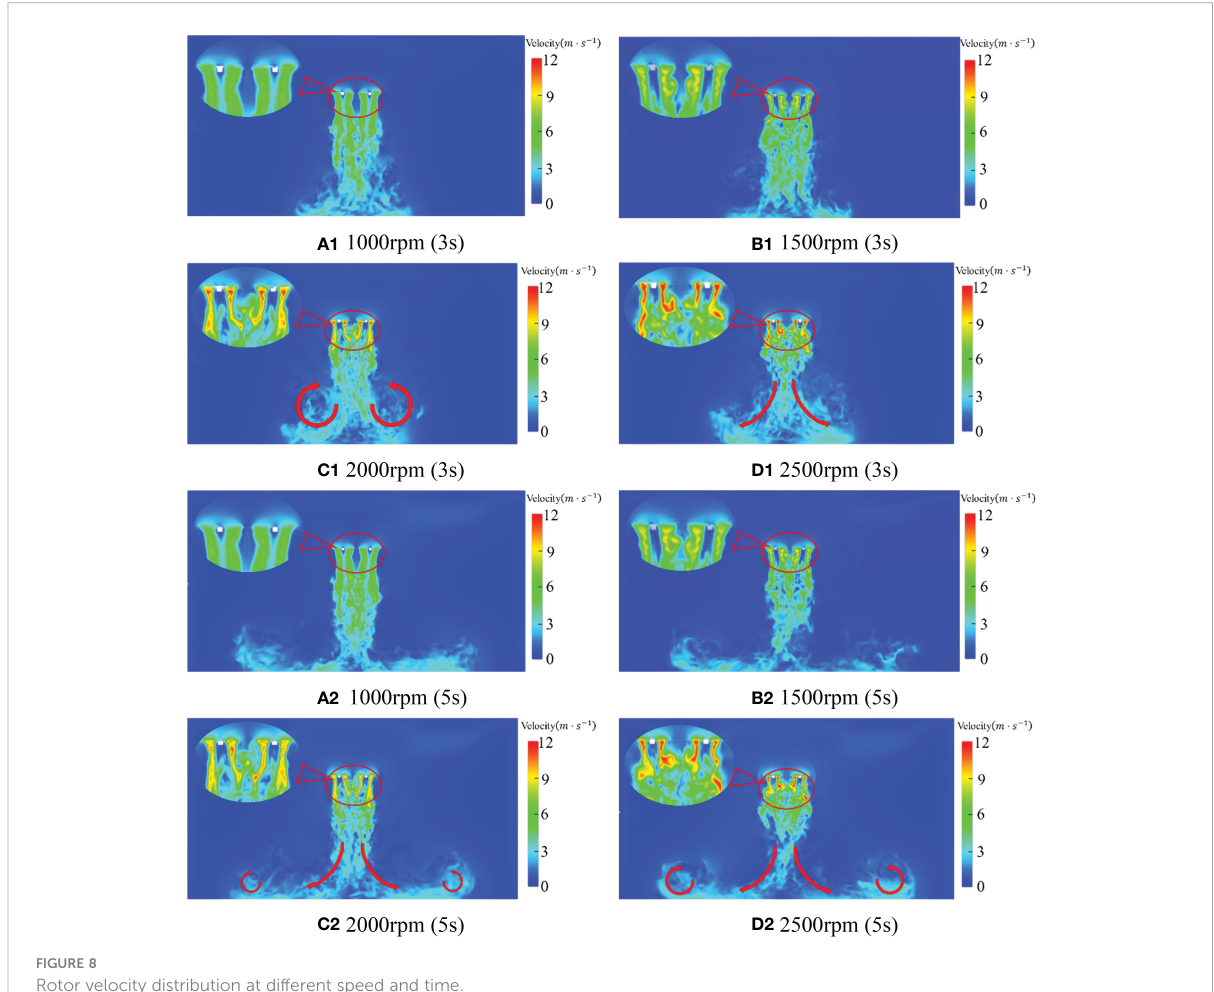
FIGURE 8 Rotor velocity distribution at different speed and time.